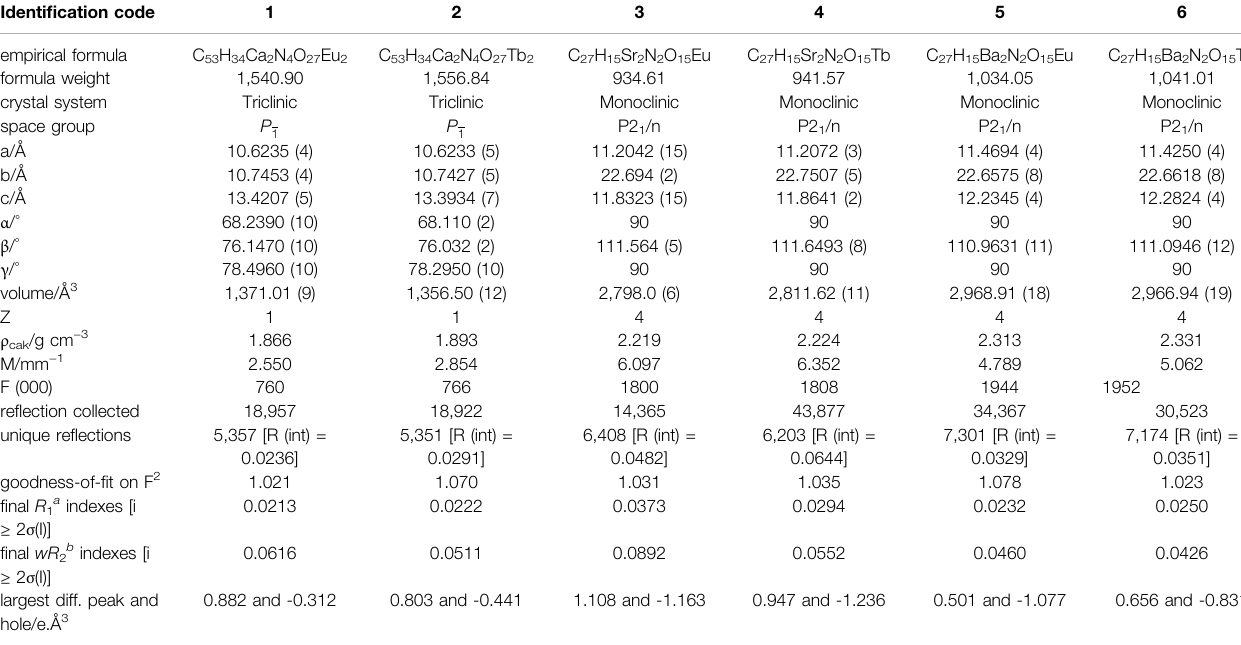
TABLE 1 | Crystallographic data and structural re fi nements for AE-Ln-CPs 1 – 6 . Identi fi cation